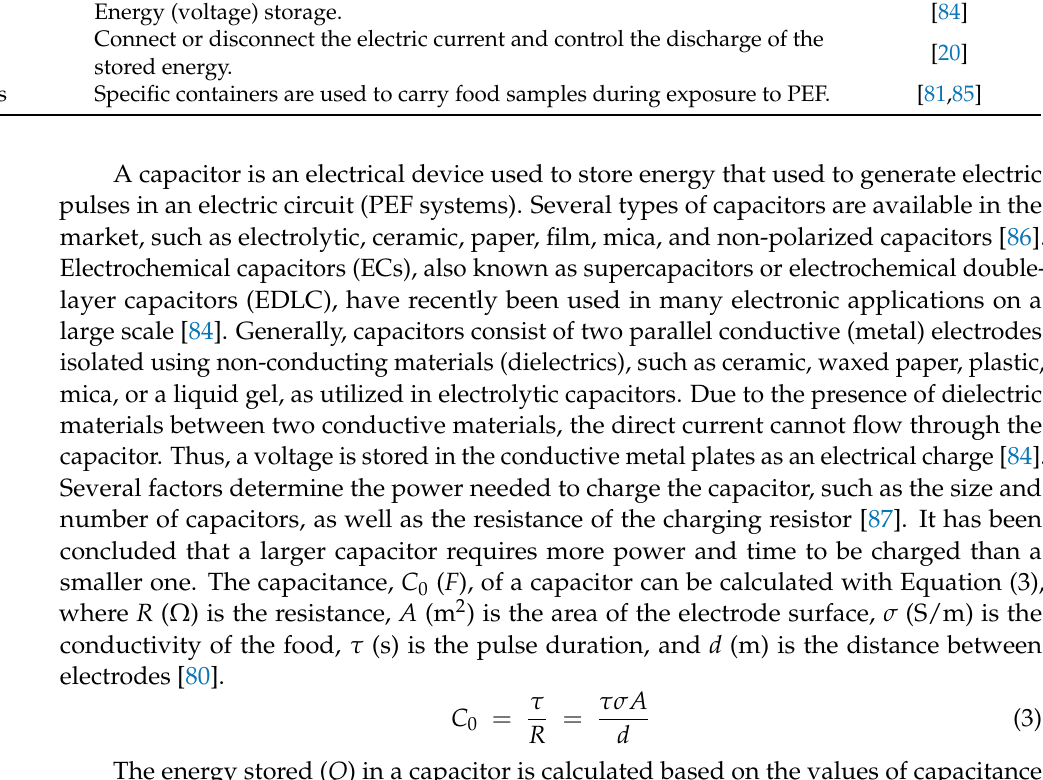
Figure 2. Schematic diagram of an electric circuit in a PEF device used for food processing.